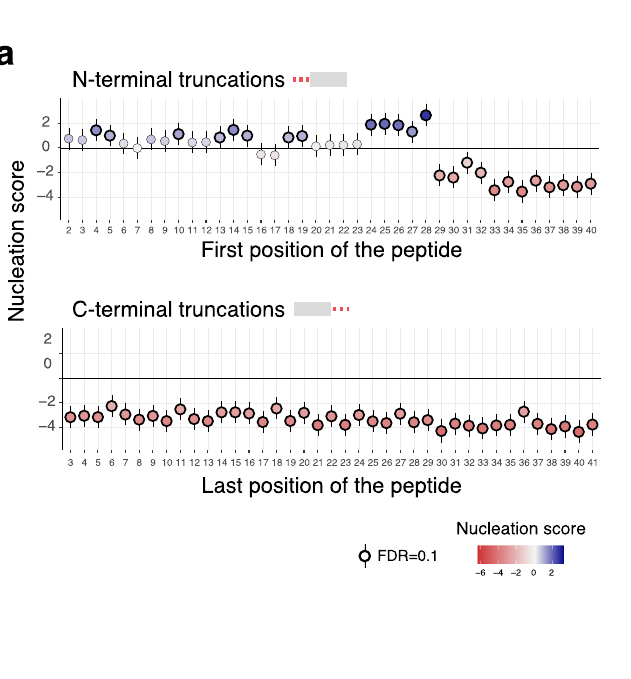
Fig. 3 | Internal multi-AA deletion atlas. a Matrix of nucleation scores for dele- tions. The dashed-line black square depicts the hotspot of deletion effects (con- secutive deleted positions where NS+frequency>½ max(NS+frequency, i.e., deletions starting atpositions 17 – 23and ending atpositions 22 – 27)and the yellow dots indicate deletions removing residues in both the N-terminus (AA 1 – 28) and C-terminus (AA 29 – 42) that increase NS (see ( e )). Variants not present are repre- sented in gray and non-nucleating variants (with no NS, see “ Methods ” ) are indi- cated with ‘ - ’ . b Effect on nucleation of deletions of 1 – 6AA length. The WT AA and position are indicated in the x-axis. The black squares indicate fAD variants: Osaka (E22 Δ ) and Uppsala ( Δ 19 – 24). Color code as in ( a ). c Frequency of variants increasing nucleation (NS+), decreasing nucleation (NS − ) or with no difference from WT (WT-like) at FDR=0.1, for sequences with a speci fi c fi rst deleted position